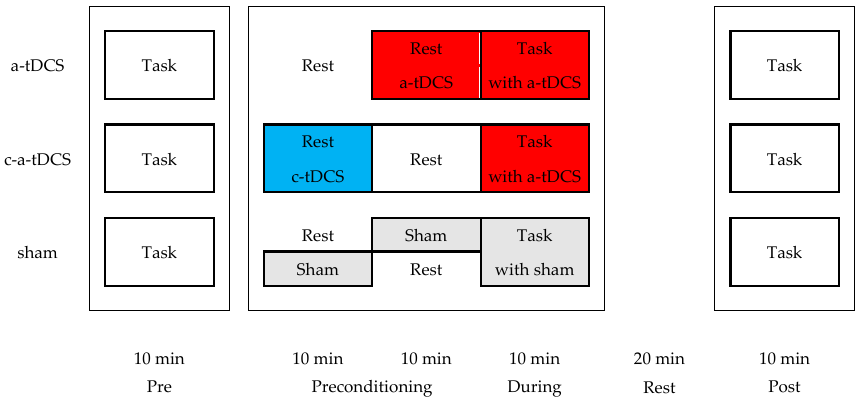
Figure 1. Schematic representation of a training day (3 blocks) for the 3 groups. The subject performed the visuo-motor task (5 trials) at three epochs interspersed by 20 min of preconditioning or delay. Pre and post times are without use of transcranial direct current stimulation (tDCS) while during depends on the specific tDCS conditions of the 3 groups exploiting different polarities (anodal: red; cathodal: blue; sham: grey) in the preconditioning phase.